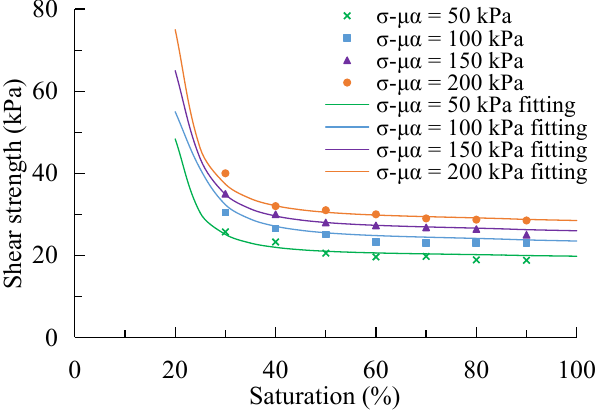
Figure 15. Experimental points and fitted curve of the shear strength at various dry densities.